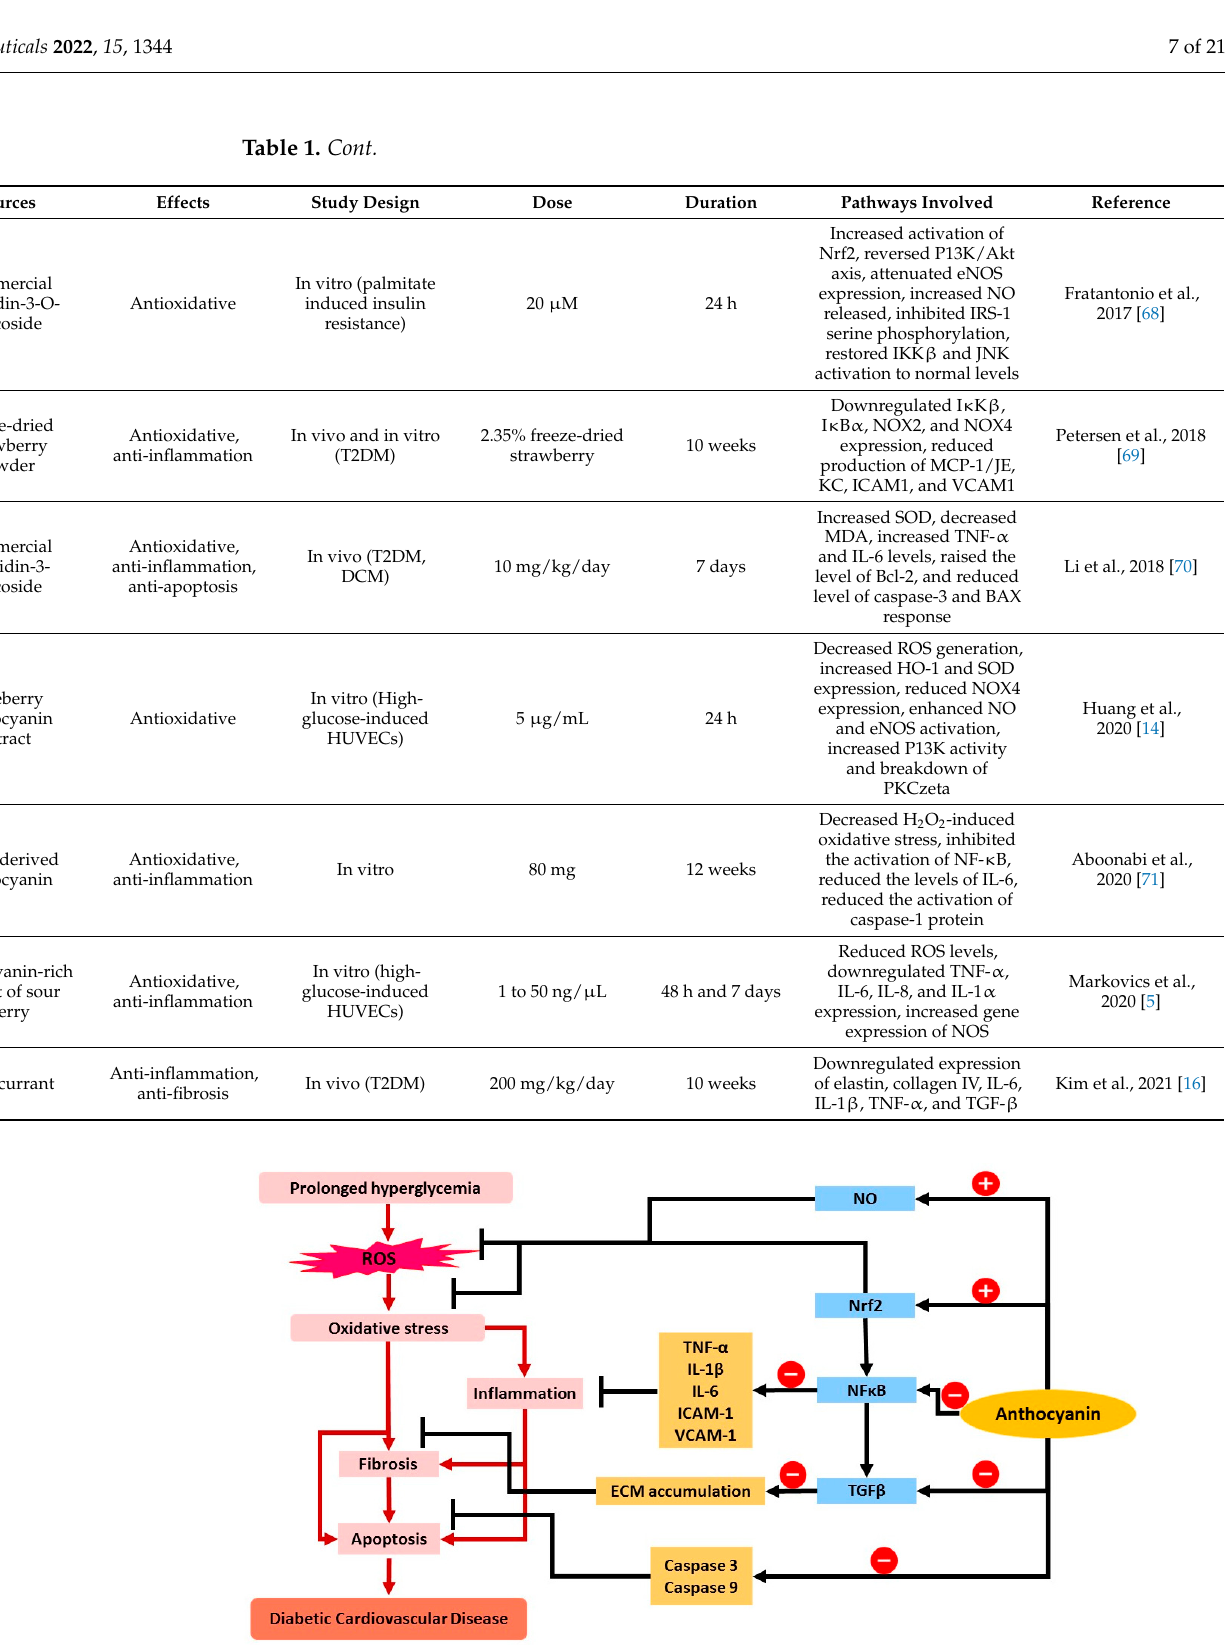
Figure 3. The summary of the role of anthocyanin in attenuating mechanisms of diabetic CVD. Anthocyanin increases NO bioactivity and upregulation of Nrf2, which induces the production of endogenous antioxidants and limits oxidative stress. Anthocyanin also has been proposed to downregulate NF- κ B and lead to reduced expression and production of cytokines involved (TNF- α , IL-1 β , IL-6, ICAM-1, VCAM-1) and further reduces the inflammatory response. NF- κ B downregulates TGF- β expression as well as anthocyanin treatment, and causes reduced ECM accumulation and limits fibrosis. Anthocyanin also reduces caspase-3 and caspase-9 levels, which further attenuates apoptosis. Abbreviations: ROS, reactive oxygen species; NO, nitric oxide; Nrf2, nuclear factor erythroid 2-related factor 2; NF- κ B, nuclear factor kappa-light-chain-enhancer of activated B cells; TGF- β , transforming growth factor beta; TNF- α , tumor necrosis factor alpha; IL, interleukin; ICAM, intercellular adhesion molecule 1; VCAM, vascular cell adhesion protein 1; ECM, extracellular ma- trix. (-) sign indicates the inhibition/downregulation of related gene/protein. Black arrow indicates the activity of anthocyanin while red arrow indicates the subsequent event/product in the pathway. 4.1. Antioxidative Anthocyanin has been studied widely due to its antioxidant activity. In a previous study, anthocyanin-rich tart cherry extract was able to prevent the decrease in water-sol- uble antioxidant capacity and increased superoxide dismutase (SOD) activity in type 2 DM (T2DM) models [10]. Furthermore, Huang and his colleagues [14] have demonstrated that administrations of blueberry anthocyanin extract, malvidin, malvidin-3-glucoside, and malvidin-3-galactoside were able to significantly ameliorate injured endothelial cells, induced by high glucose level, by elevating endogenous SOD and heme oxygenase-1 (HO- 1), lowering ROS production, and downregulating NADPH oxidase isoform 4 (NOX4) expression. The same study also showed that anthocyanin effectively induced vasodila- tory effects by increasing nitric oxide (NO) and its promoter, endothelial NO synthase (eNOS), and peroxisome proliferator-activated receptor- γ (PPAR γ ) levels, decreasing the vasoconstrictor angiotensin-converting enzyme (ACE), xanthine oxidase-1 (XO-1), and low-density lipoprotein (LDL) levels, as well as via the activation of the phosphoinositide 3-kinase (PI3K)/Akt signaling pathway and the breakdown of the PKC ζ pathway. In addition, cyanidin 3-glucoside, an anthocyanin, has been reported to exhibit anti- oxidative properties by elevating SOD activity and diminishing malondialdehyde (MDA) content in diabetic hearts [70]. A recent study demonstrated that anthocyanin derived from berries exerted cytoprotective effects against H 2 O 2 -induced oxidative stress in dia- betic aortic endothelial cells by attenuating cytotoxicity induced by H 2 O 2 [71]. Interest- ingly, anthocyanin has been reported to significantly reduce the levels of ROS-generating enzymes, NOX2 and NOX4, indicating that anthocyanin contributes to limiting oxidative stress in diabetic vasculature [67]. In an in vitro study, anthocyanin-rich sour cherry ex- tract exhibited potent radical scavenging capacity by significantly reducing ROS in